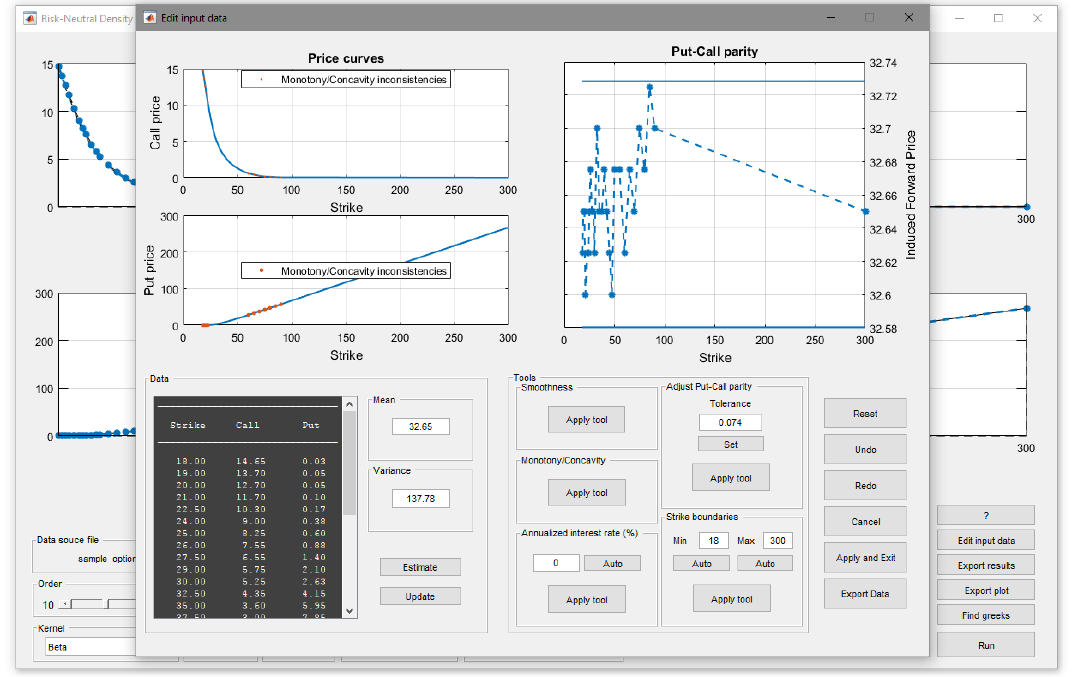
Figure 2. The imported dataset of volatility index (VIX) options observed on 16 November 2011.